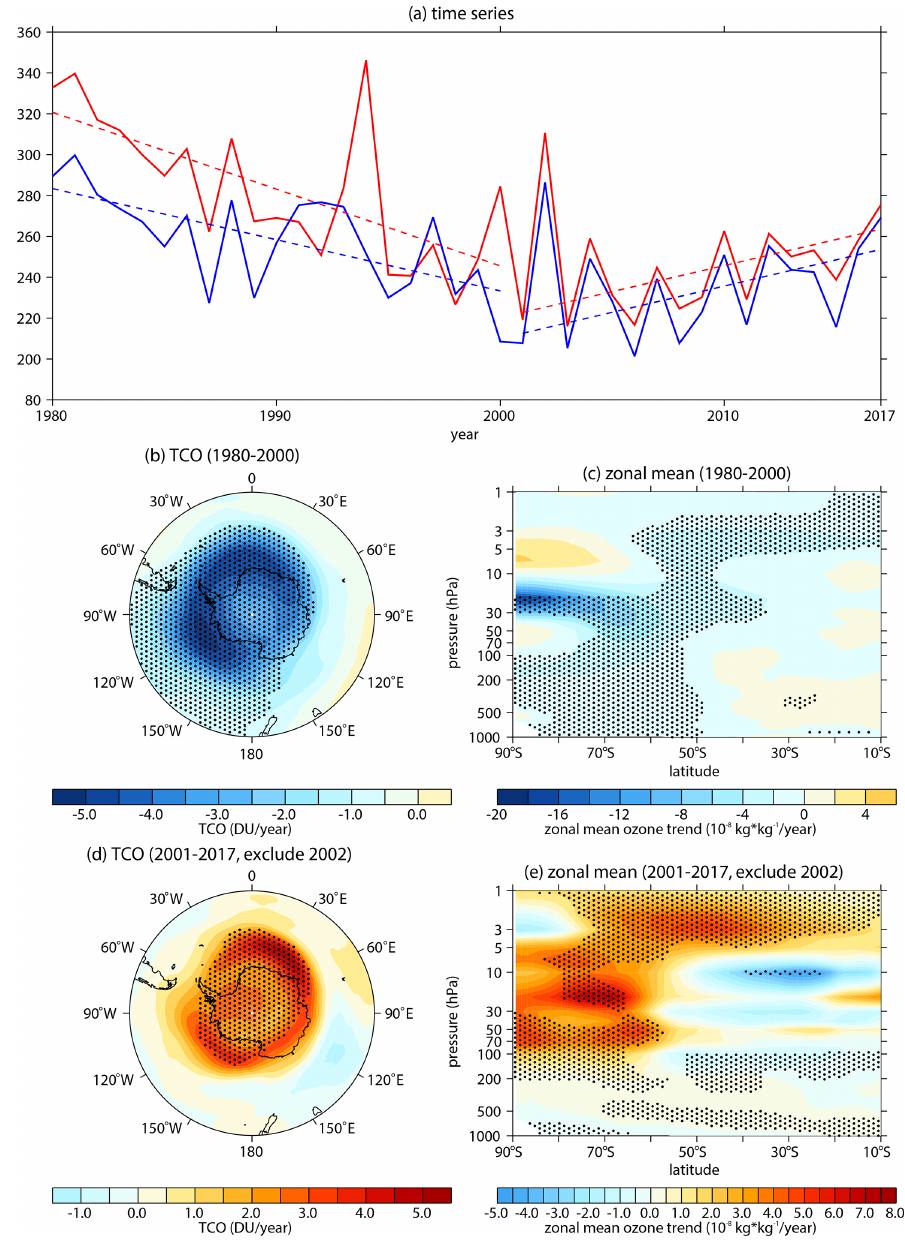
Figure 4. (a) Time series (solid lines) of area-weighted total column ozone (TCO) over 60 to 90 ◦ S as derived from the MERRA-2 (red) and SBUV (blue) datasets. The dashed lines represent linear regression of TCO. (b, d) The TCO trends in September during 1980–2000 (b) and 2001–2017 (d) as derived from the MERRA-2 dataset. The outermost latitudes in panels (c, d) are both 40 ◦ S. (c, e) The zonal mean ozone trends on the latitude pressure profile in September during 1980–2000 (c) and 2001–2017 (e) as derived from the MERRA-2 dataset. The stippled regions in panels (b) – (e) represent trends significant at/above the 90% confidence level. Data from 2002 are removed when trends, regressions, and significances are calculated in this